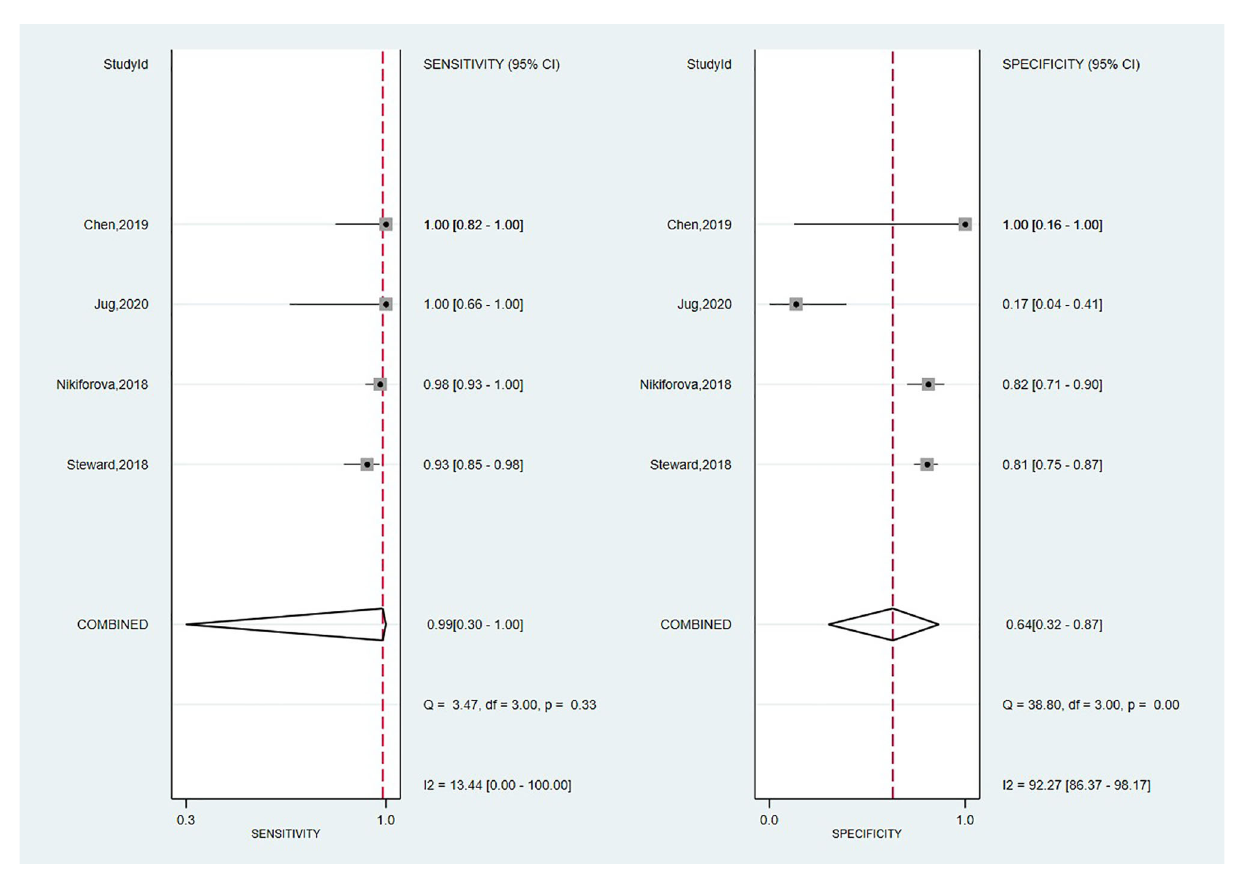
FIGURE 3 | Forest plot of sensitivity and speci fi city for Thyroseq v3.